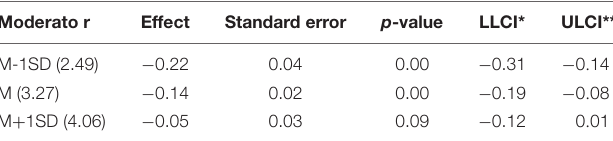
TABLE 6 | Conditional effect of Authentic leadership according to co-worker undermining and PsyCap. Moderato r